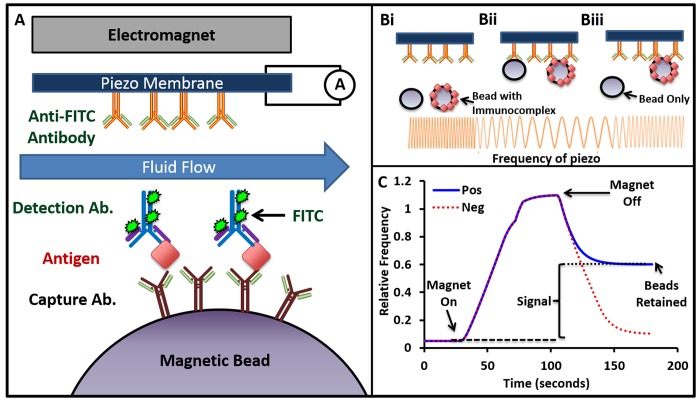
Detection Scheme.A. The c.Ab. is covalently bound to a magnetic bead that is incubated with sample and fluorescein-tagged d.Ab. This sample is introduced into a flow cell capped with a piezo-electric membrane coated with an anti-fluorescein antibody. An electromagnet above the membrane is controlled with embedded software. B. Upon magnetic perturbation, all beads (black circles) move towards the membrane (Bi), and beads with a completed immunocomplex (black circles coated with red dots) bind to the anti-fluorescein antibody (Bii). After the field is removed and flow restored, only beads with a completed immunocomplex remain bound (Biii). These beads alter the oscillation of the membrane (represented as orange sinusoidal curve), which is interpreted as signal in arbitrary units [36]. See S1 Video. In B, the solid blue line labeled Pos refers to beads in the presence of antigen, and the dotted red line labeled Neg refers to beads in the absence of antigen.